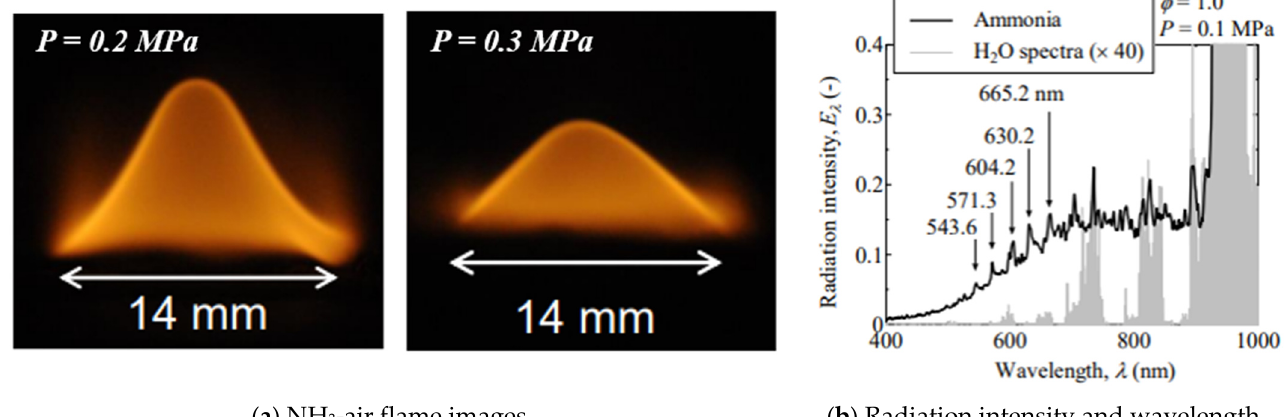
Figure 3. NH 3 -air flames stabilized on the nozzle-type burner and radiation intensity analysis: ( a ) Images of NH 3 -air pre- mixed flame at stoichiometric condition; ( b ) Relationship between radiation intensity, E λ , and wavelength, λ , of φ = 1.0 at p = 0.1 MPa. Modified from [59]. Courtesy of the Japan Society of Mechanical Engineers [59].